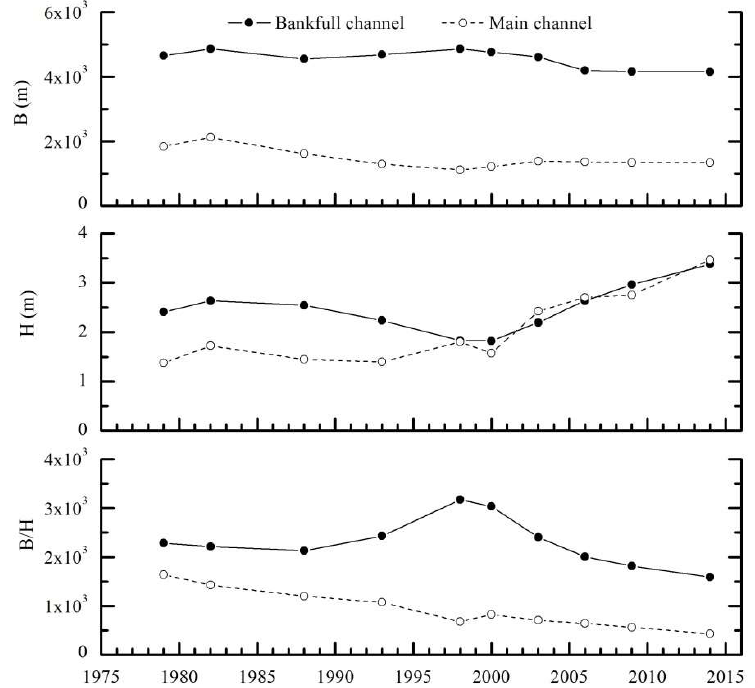
Figure 13. Reach-scale variations of the width ( B ), depth ( H ), and width/depth ratio ( B/H ) of bankfull and main channels measured in the pro-flood season from 1979 to 2015.